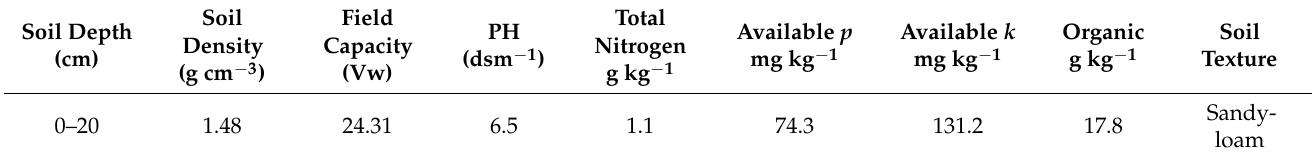
Table 1. Soil characteristics of the experiment